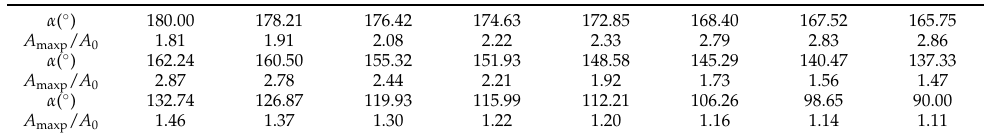
Table 3. The calculated wave amplitude increases at the focal points corresponding to different angles α .